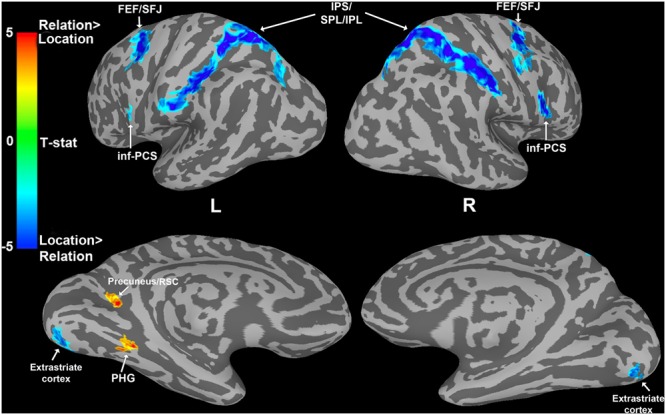
Whole-brain analysis results showing a dissociation between Location and Relation trials during the WM delay period. Cooler colors indicate areas significantly more active for Location than Relation trials. Warmer colors indicate areas significantly more active for Relation than Location trials. Abbreviations: frontal eye fields (FEF), superior frontal junction (SFJ), intraparietal sulcus (IPS), superior/inferior parietal lobule (S/IPL), inferior precentral sulcus (inf-PCS), retrosplenial cortex (RSC), and parahippocampal gyrus (PHG).